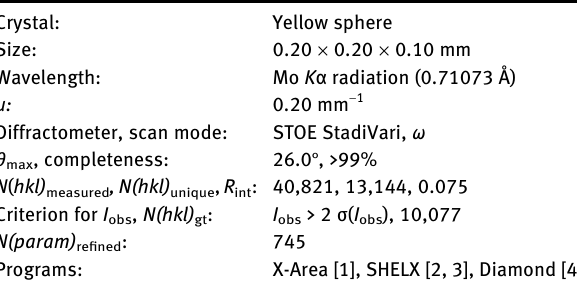
Table  : Fractional atomic coordinates and isotropic or equivalent isotropic displacement parameters (Å 